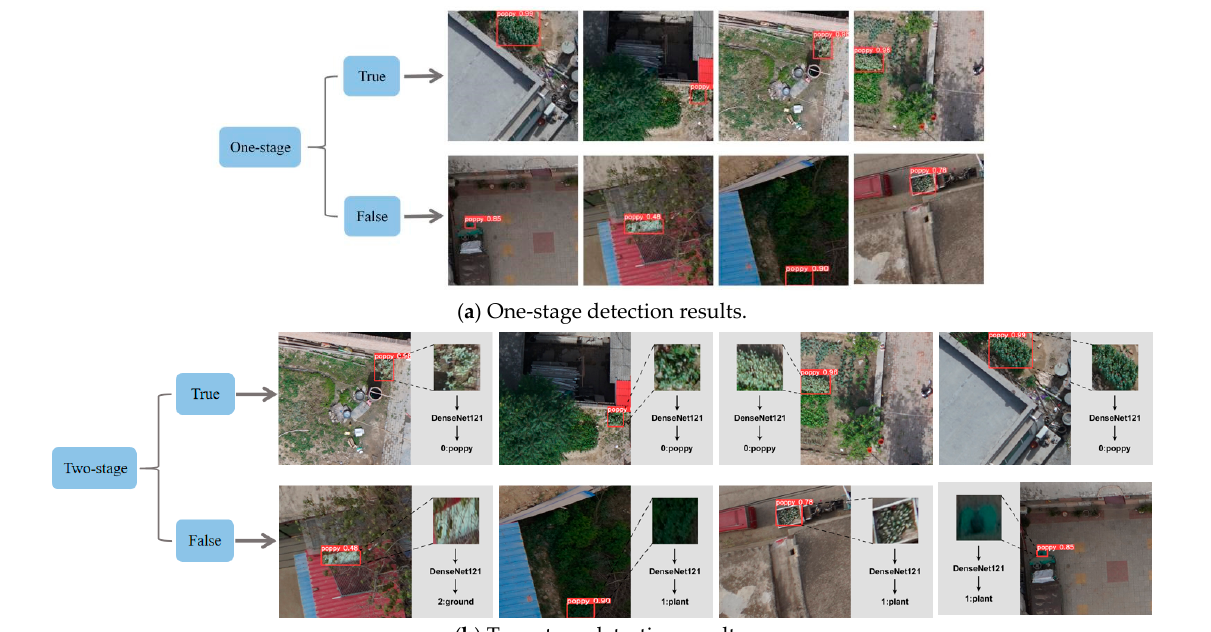
Figure 7. One-stage and Two-stage detection results.